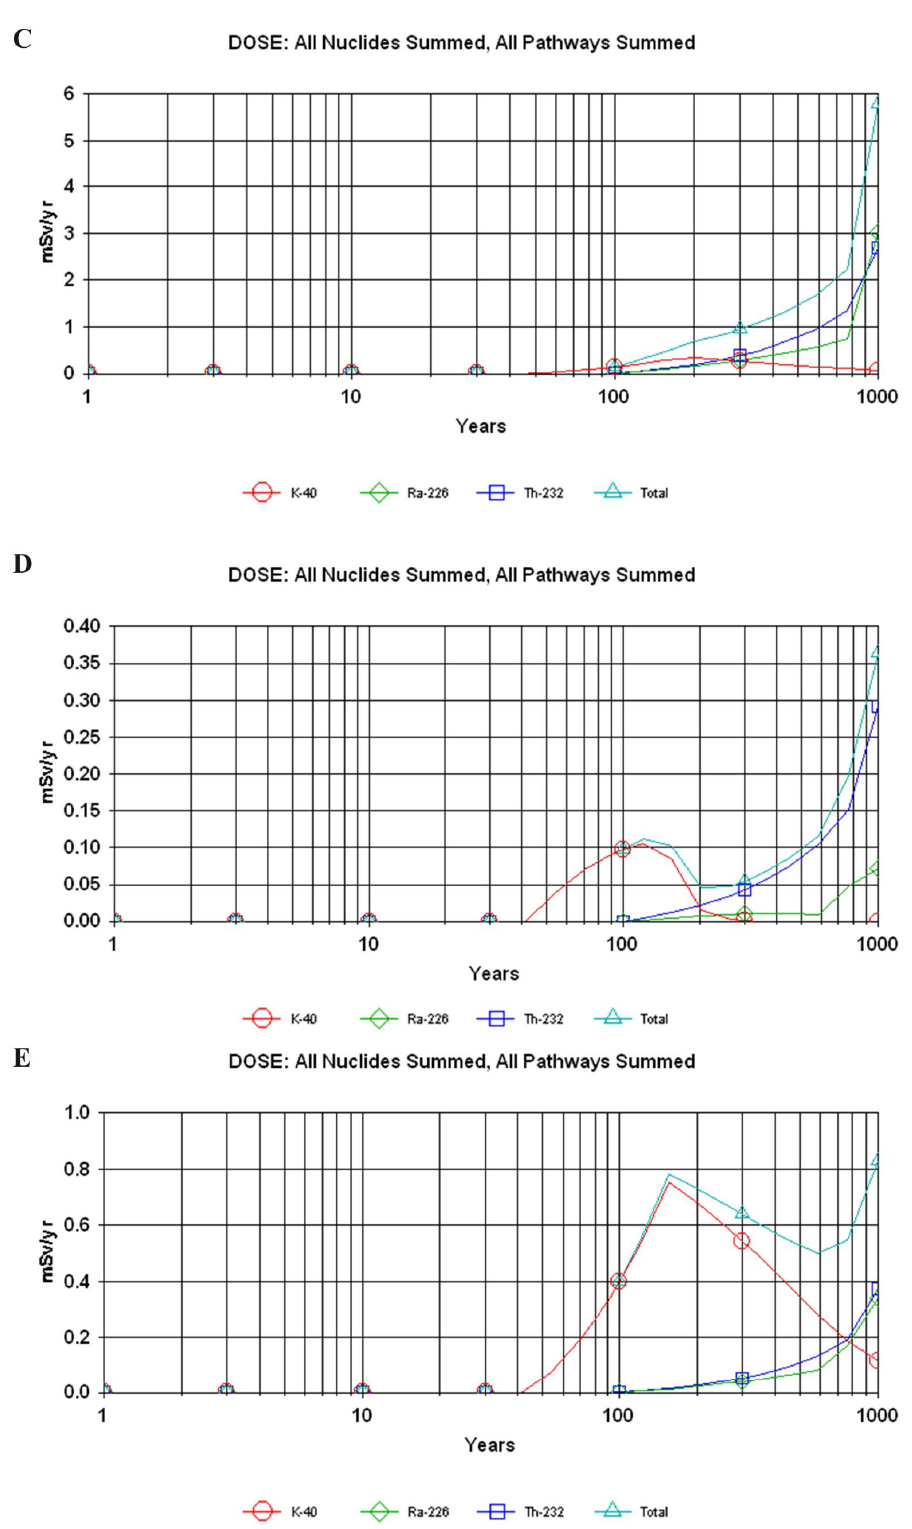
Figure 6. Total annual dose of all radionuclides using a cover (1 m). ( A ) Ajka coal, ( B ) Ajka red mud, ( C ) Almásfüzitő red mud, ( D ) Zalatárnok drilling mud, ( E ) Ú rkút manganese. RESRAD-BIOTA code was used to estimate the radiation exposure of terrestrial or- ganisms (plants and animals). Table 4 shows the values of the sum ratio factor, biota con- centration guide (BCG), external dose, internal dose, and total dose of the investigated radionuclide in terrestrial plants by soil media. Table 4. The sum ratio factor, biota concentration guide (BCG), external dose, internal dose, and total dose of the investigated radionuclide in terrestrial plant by soil media. Risk Parameter